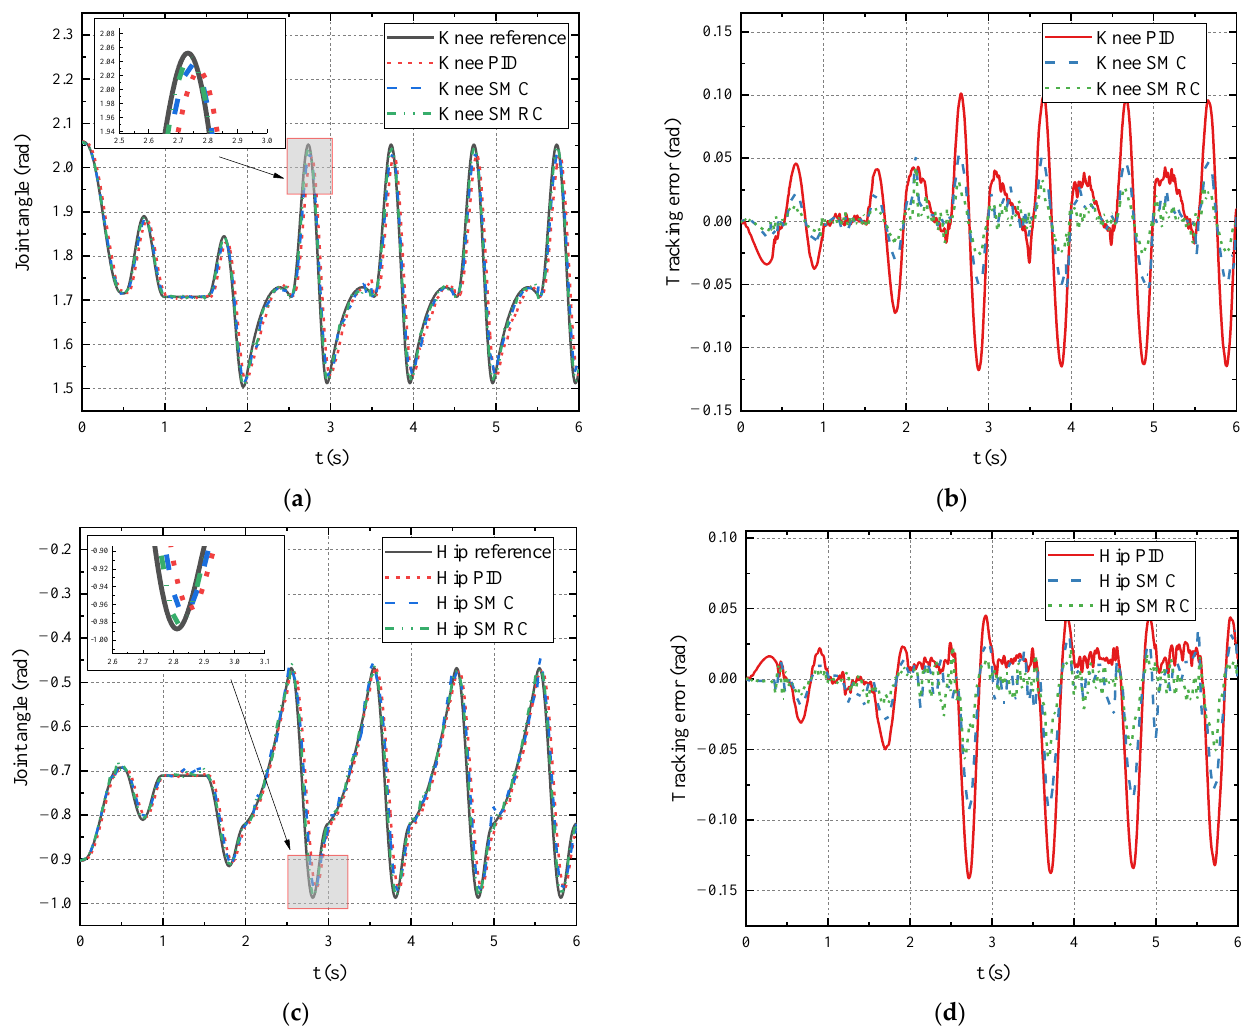
Figure 9. Comparison of PID, SMC, and SMRC in joint trajectory tracking and error: ( a ) Knee trajectory; ( b ) Knee tracking error; ( c ) Hip trajectory; ( d ) Hip tracking error.